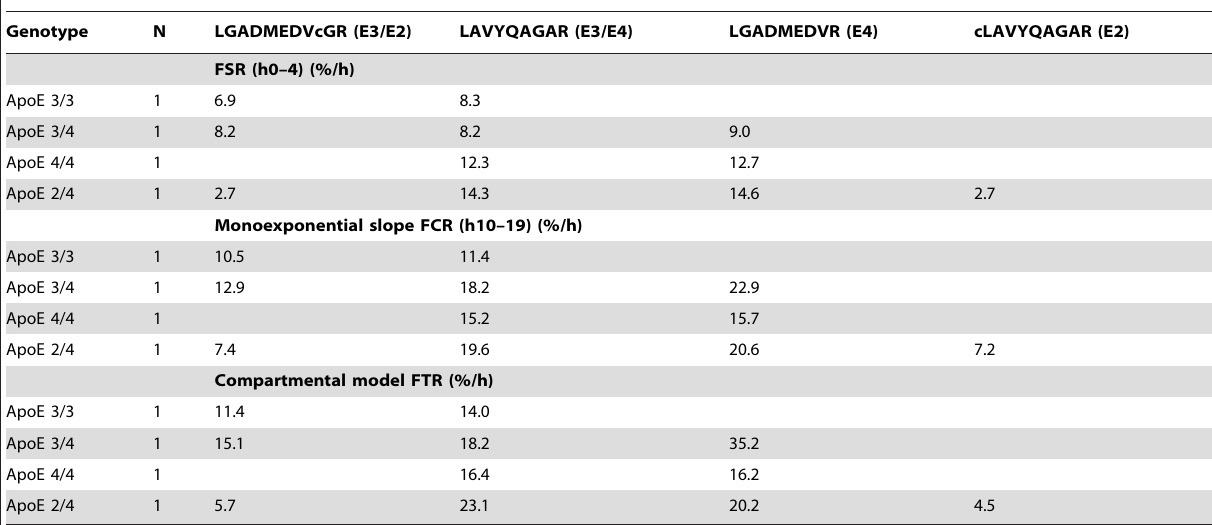
Table 1. Peripheral Plasma ApoE Kinetic Parameters.